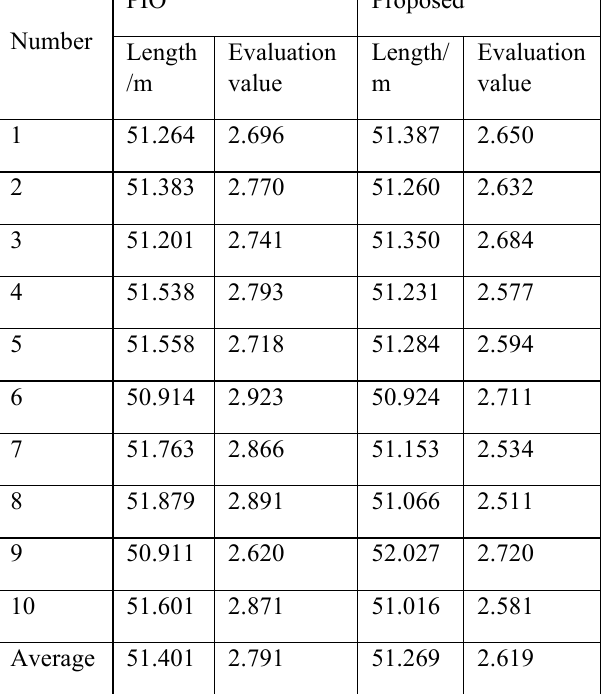
Table 3. Performance comparison between traditional PIO and the proposed algorithm under environment 1